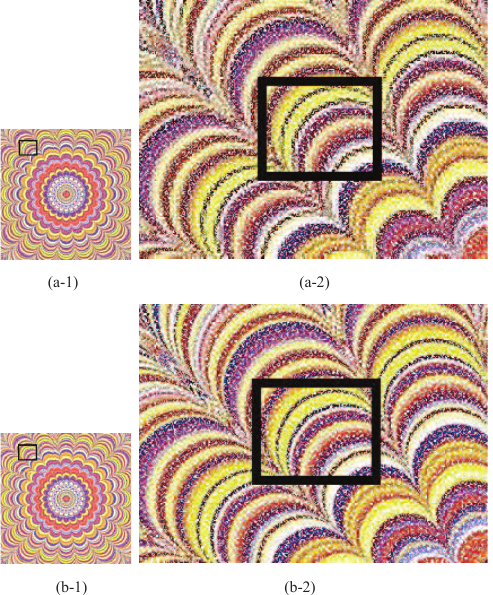
Figure 17. Color meaningful shadows and enlarged parts of cropped image area for ( 3,3 ) -SDIS: ( a ) using the original method ( b ) using the approach of enhancing visual